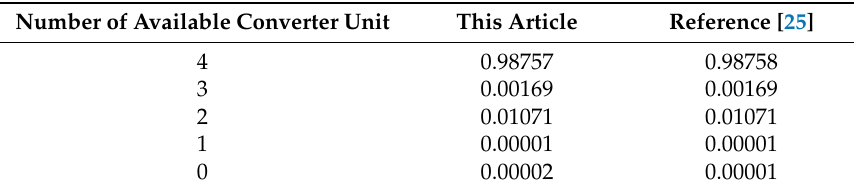
Table 2. Comparison of reliability indices in terms of state reliability.